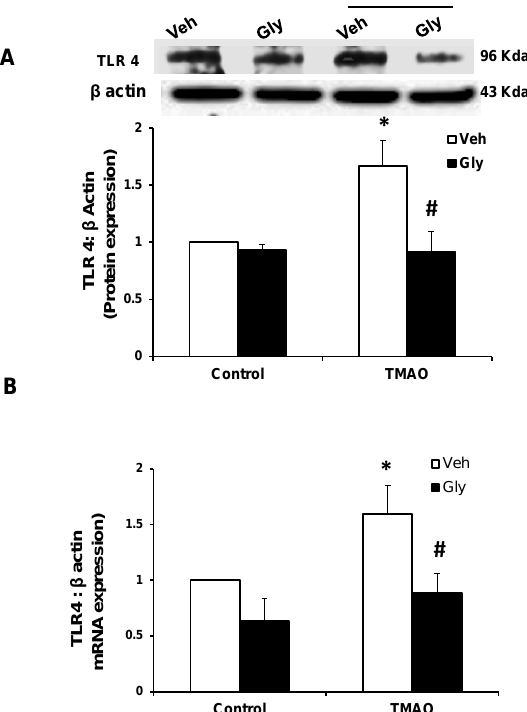
Figure 6. E ff ects of HMGB1 inhibition by glycyrrhizin on TMAO-induced toll-like receptor 4 (TLR4) expression in EOMAs. Representative Western blot images ( A ) and RT-PCR ( B ) analysis show the TLR4 expression in EOMAs with or without stimulation of TMAO and / or HMGB1 inhibitor glycyrrhizin. n = 5. Veh: vehicle. * significant di ff erence from control, # significant di ff erence from